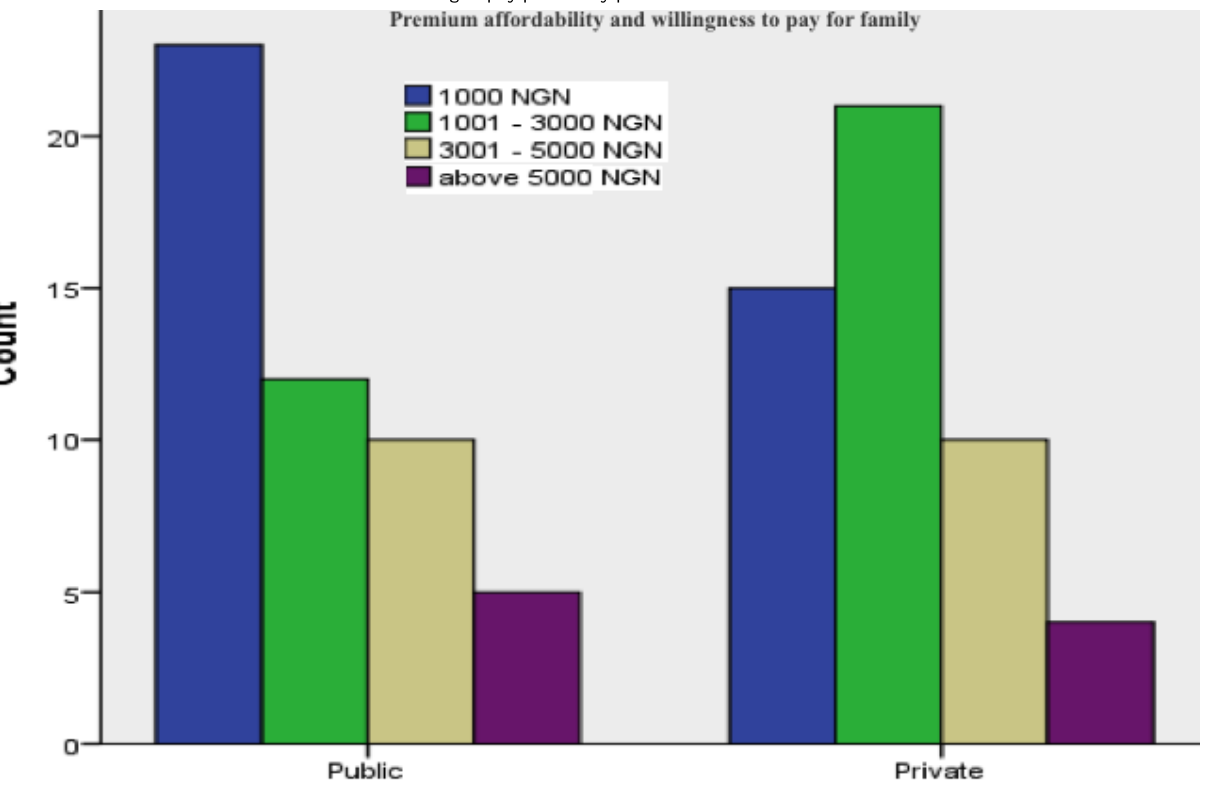
Figure 4. Premium that the interviewed clients are willing to pay per family per